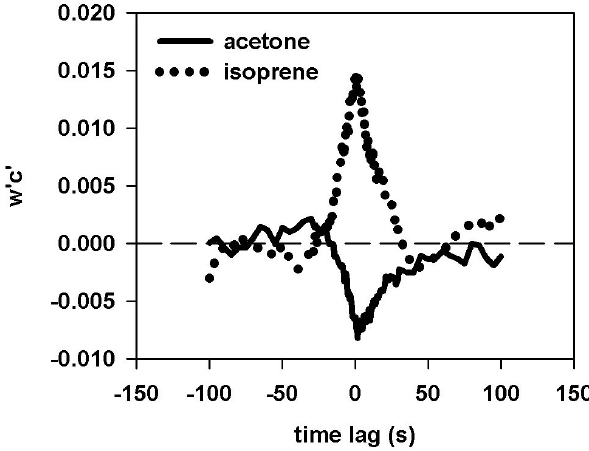
Fig. 4. Lag covariance plot of acetone and isoprene for the morning of day 210 of 2007, during which negative fluxes of acetone were